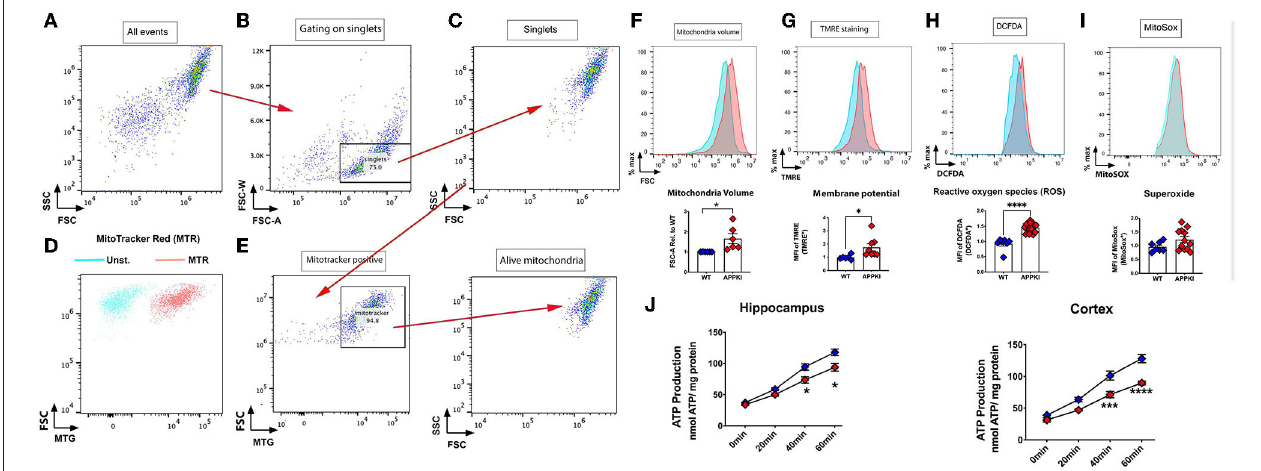
FIGURE 6 | Mitochondrial dysfunction was observed in 7-m APPKI mice brain. (A) Isolated hippocampal mitochondria are visualized on a dot plot. (B) Doublets and singlets can be visualized by plotting FSC vs. FSC-W (linear mode). Doublets are excluded if the FSC-W value is more than two times the mean FSC-W value of the majority of events. Events under this threshold are gated as singlets. (C) Change the mode to dot plot again to visualize the gated singlet events to continue gating on the remaining events. (D,E) The unstained sample (blue events) and sample stained with a mitochondria-specific dye, MitoTracker Red (red events). Singlets were gated by MitoTracker and characterized for: (F) mitochondrial volume; (G) mitochondrial membrane potential; (H) ROS; (I) superoxide. (J) Decreased ATP production from purified mitochondria from hippocampal and cortical tissues. Data are presented as mean ± SEM; n = 3–4 mice per group with duplicates from each mouse. Data were analyzed using Student’s t -test for F–I and two-way ANOVA for J. Significance was assumed when p < 0.05. * p < 0.05, *** p < 0.005, **** p < 0.001.